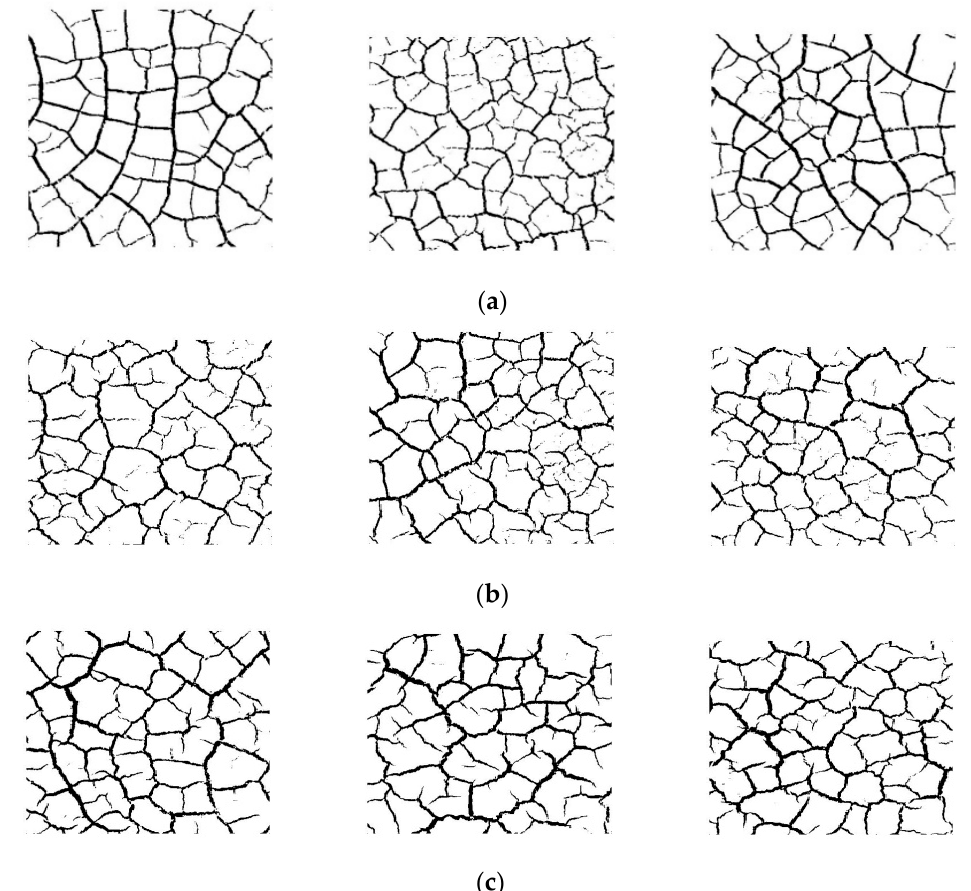
Figure 11. Soil sample wet and dry cycle binarized fissure diagram. ( a ) The fissure morphology of the first dry–wet cycle of soil samples; ( b ) the fissure morphology of the second dry–wet cycle of soil samples; ( c ) the fissure morphology of the third dry–wet cycle of soil samples.